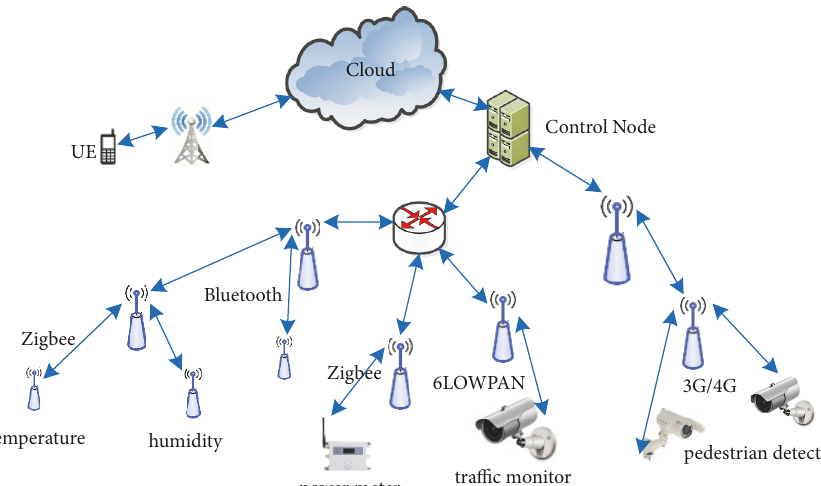
Figure 1: WSNs application in traffic